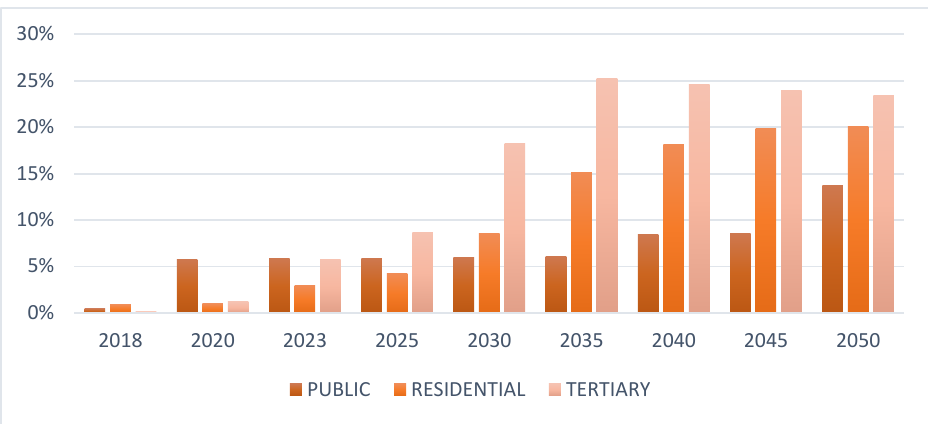
Figure 10. Renewables share in end-use electricity consumption for supply sectors ( HIGH scenario).